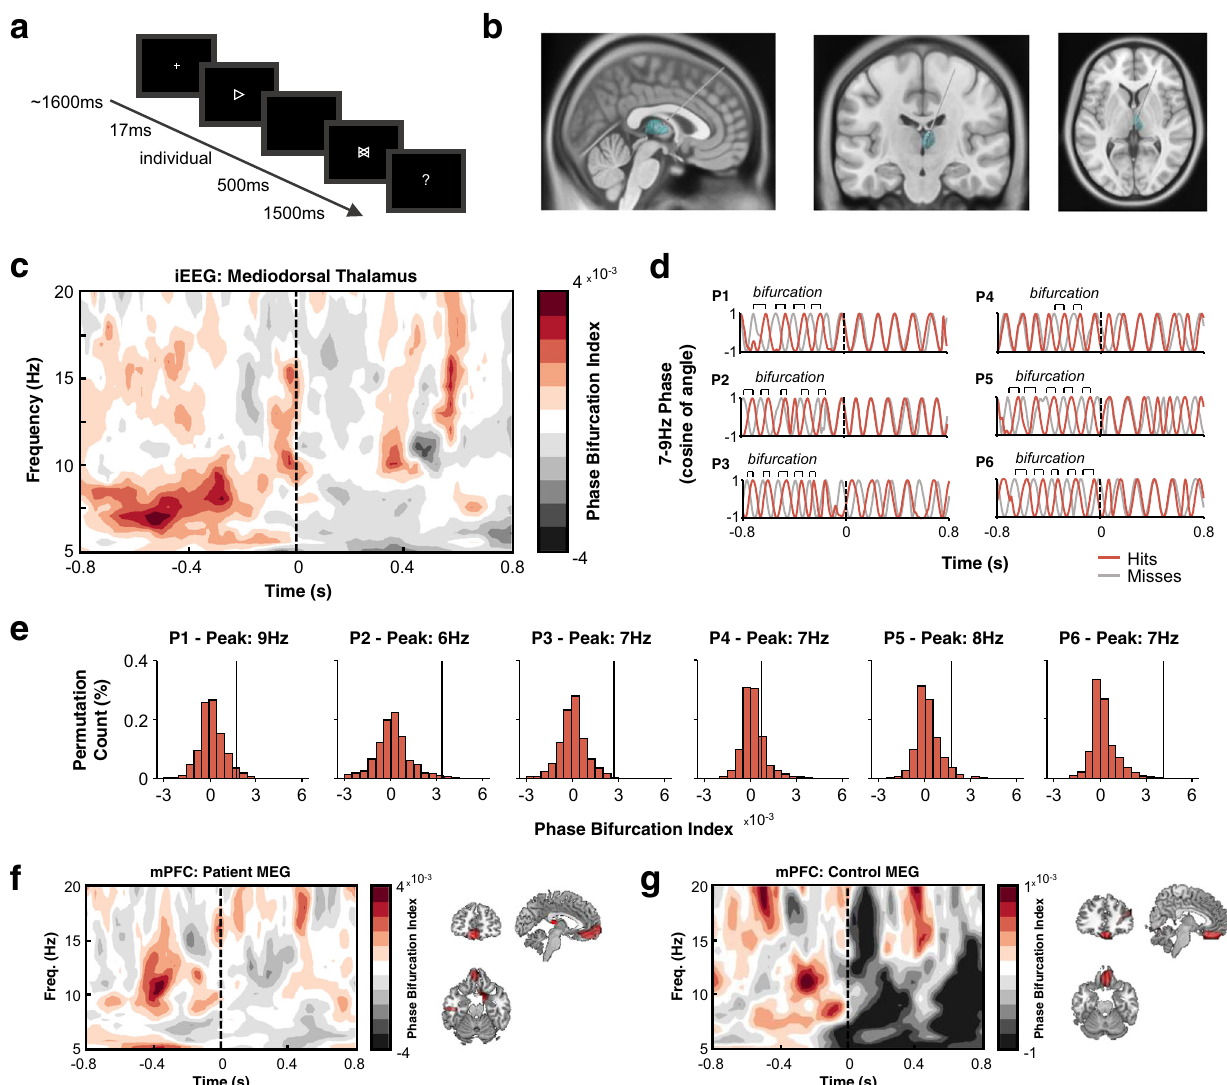
-0.8 Fig. 1 Phase bifurcation within the mediodorsal thalamus precedes visual detection. a Experiment overview. Participants completed a visual detection screen in which an arrow (pointed left or right) was brie fl y shown before a mask appeared. Participants then indicated which direction they thought the arrow was pointing. b Deep brain stimulation electrodes were implanted in the left and right mediodorsal and anterior thalami. See Supplementary Fig. 1 for visualisation of mediodorsal thalamus in the context of other thalamic nuclei. c Time-frequency representation depicting mean mediodorsal thalamic phase bifurcation across patients (as measured with iEEG). Higher values indicate greater phase bifurcation (coloured in a deep red; the lowest phase bifurcation values are coloured in dark grey). Time at 0 s represents onset of the target. Substantial low-frequency phase bifurcation was observed prior to stimulus onset. d Bandpass- fi ltered (7 – 9 Hz) mediodorsal thalamic signal for each participant individually (hits in red; misses in grey). The phases of the two conditions are opposed in all patients. e Patient-speci fi c observed phase-bifurcation (black line) compared to a surrogate distribution (red histograms; n = 1000 permutations) for individual peak bifurcation frequencies. The comparatively slow frequency effect of participant 2 did not impact the group effect (see Supplementary Fig. 3). f MEG-recorded time-frequency representation (left; colour scheme as in c ) of medial prefrontal phase-bifurcation in patients and source-localisation of the peak of this effect (right; visualised phase bifurcation at − 400ms, 10 Hz; coloured in red; MNI: [ − 4, 50, − 21]). g MEG-recorded time-frequency representation of medial prefrontal phase-bifurcation (left; colour scheme as in c ) in healthy controls and source- localisation of the peak of this effect (right; visualised phase bifurcation at − 300 ms, 11 Hz; coloured in red; MNI: [5, 36, − 24]). iEEG intracranial electroencephalography, MEG magnetoencephalography, mPFC medial prefrontal cortex. Source data are provided as a Source Data fi